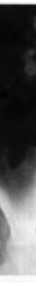
FIGURE 1. Intravenous urography (IVU) showing bilateral normal functioning kidneys with hydroureteronephrosis.